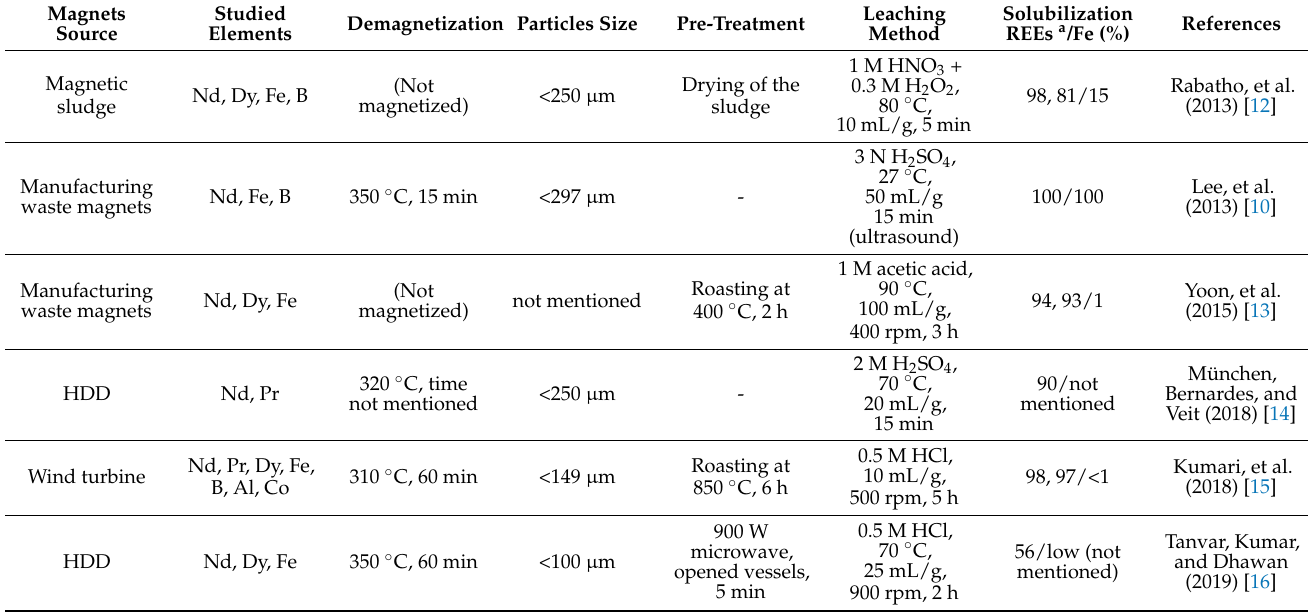
Table 1. Hydrometallurgical techniques published on the recycling of REEs from NdFeB magnets. Magnets